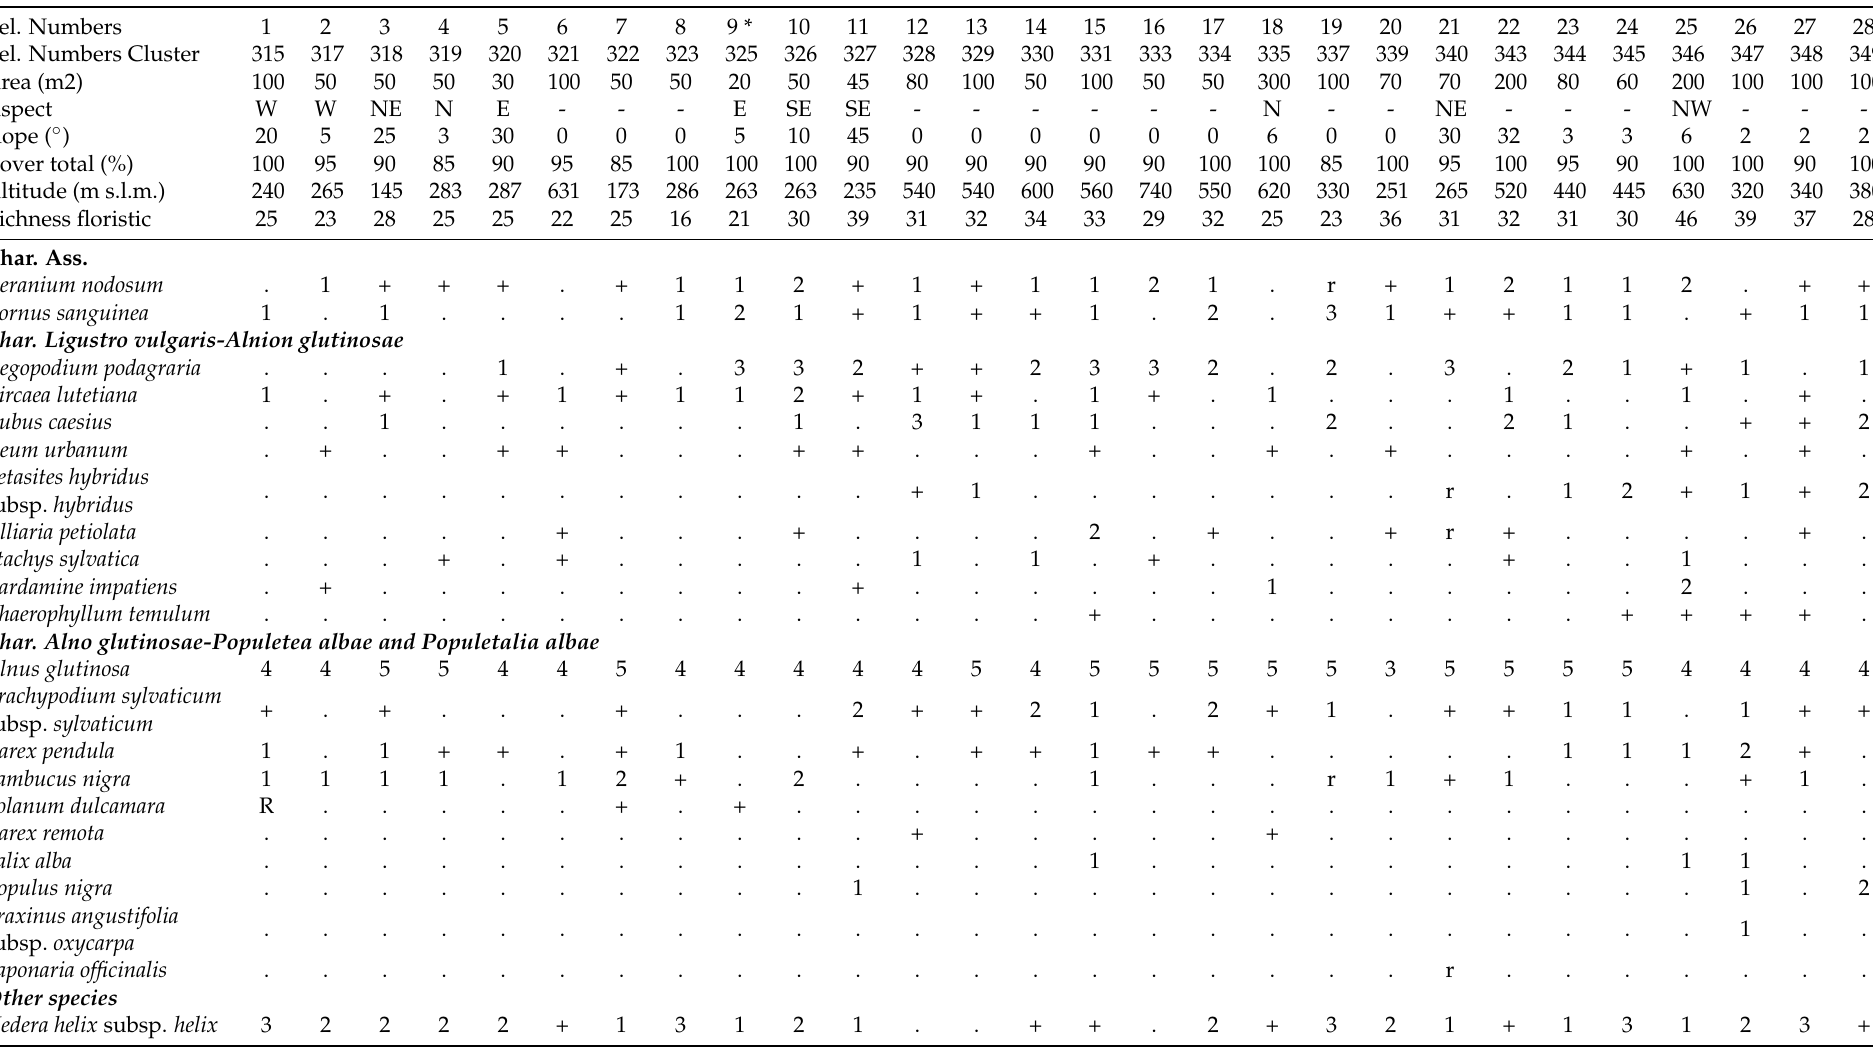
Table 3. Geranio nodosi-Alnetum glutinosae cornetosum sanguineae subass. nov. hoc loco. Appendix